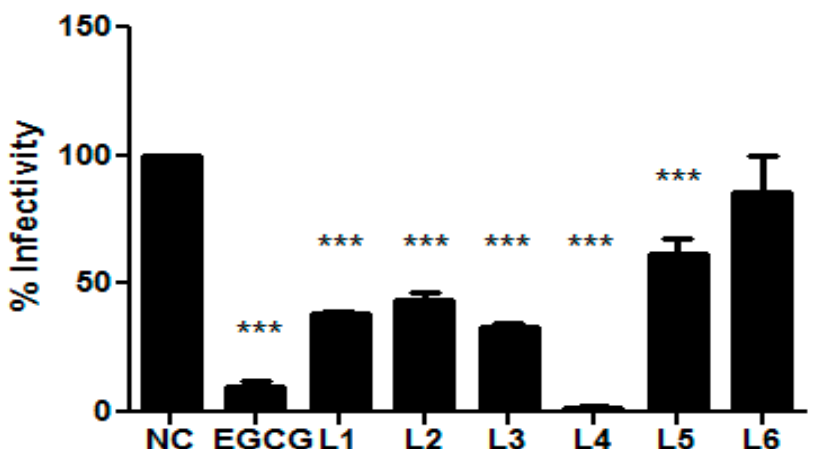
Figure 3. Hepatitis C Virus (HCV) assay: NC-Negative control, EGCG-Positive control, L1-Labindole A ( 1 ), L2-Labindole B ( 2 ), L3–L6 compound 3 – 6 . The assay was performed in quadruplicate (L1–L2) and triplicate